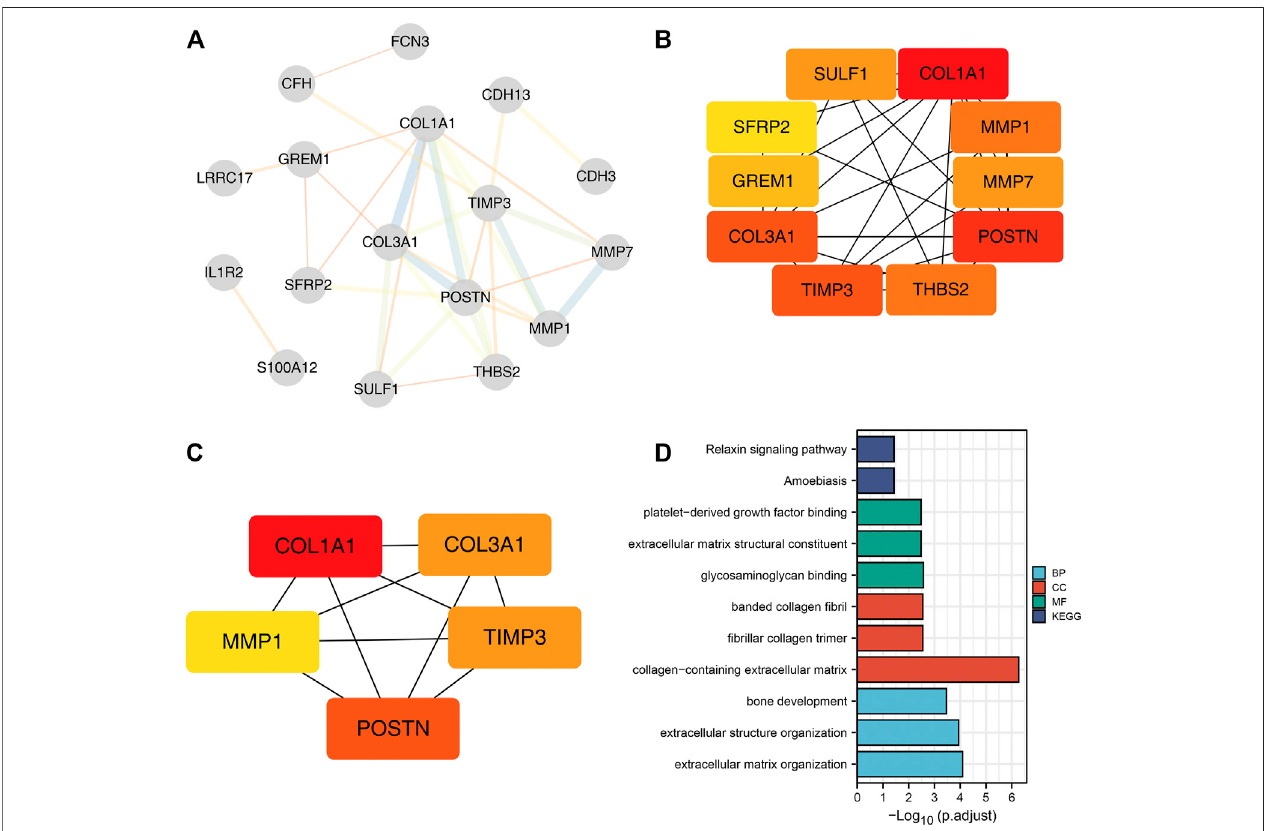
FIGURE 2| Five hub genes were identi fi ed in IPF samples. Notes: (A) : PPInetworkof the DEGs; (B) : Top ten central elements calculated byconnectivity degree in thePPInetwork; (C) :Top fi vecentralelementsnamedhubgenescalculatedbyconnectivitydegreeinthePPInetwork; (D) :GeneOntology(GO)andKyotoEncyclopedia of Genes and Genomes (KEGG) enrichment pathways were explored based on the 31 common